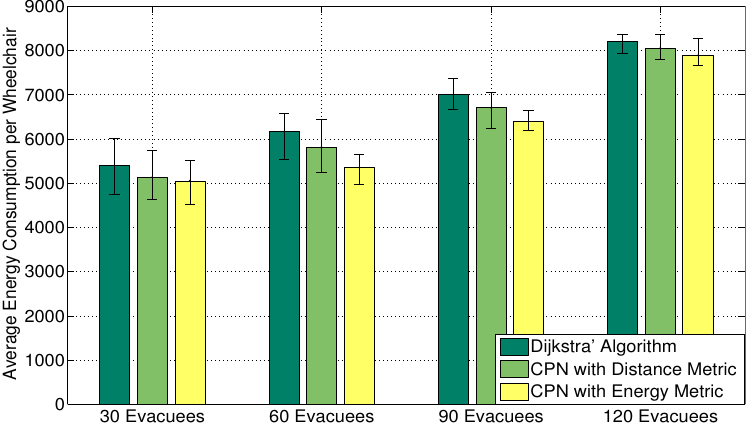
Figure 8. The average energy consumption for each electric powered wheelchair of ten iterations in energy units. The error bars represent the min/max values found in the 10